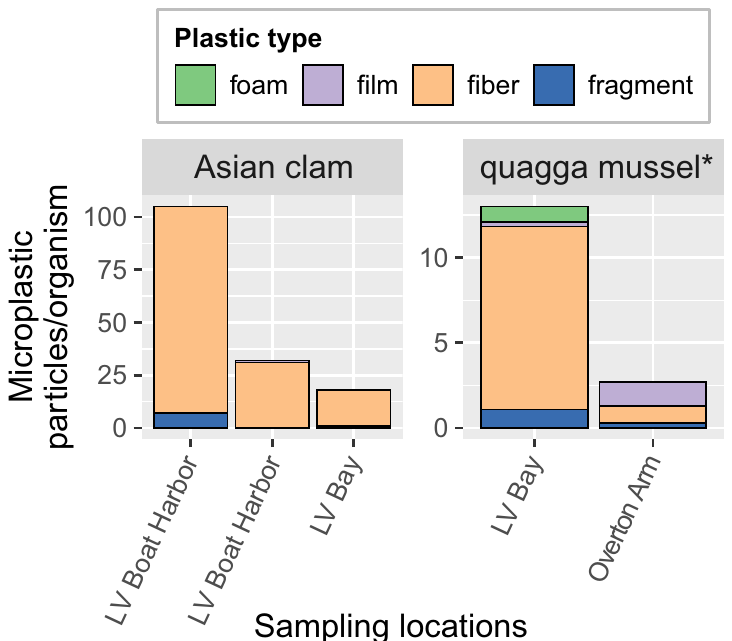
Fig 7. Concentrations of different microplastic types in Asian clams and quagga mussels, Lake Mead, 2017. � Average from 10–11 individuals, composited.